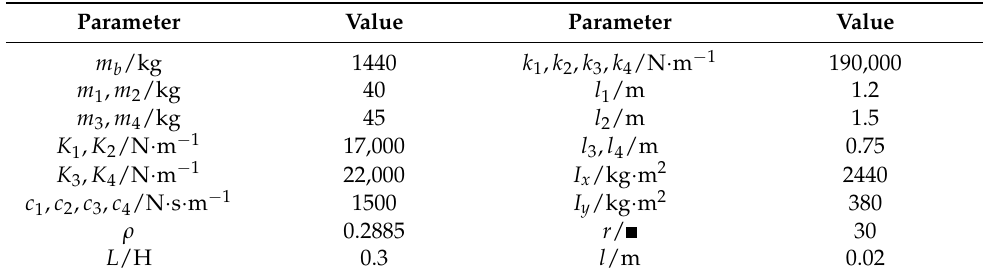
Table 3. The whole vehicle suspension system parameters